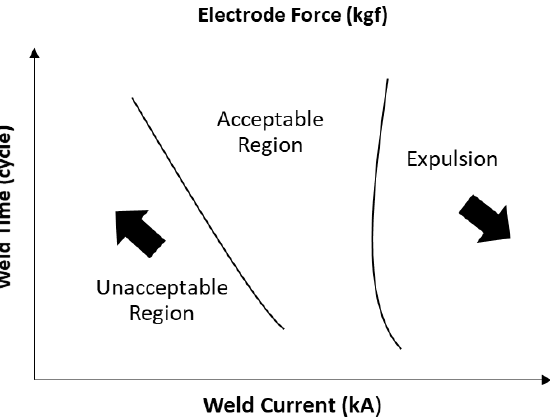
Figure 3. Controlling the welding current waveform (adapted from Hwang et al., [6]).